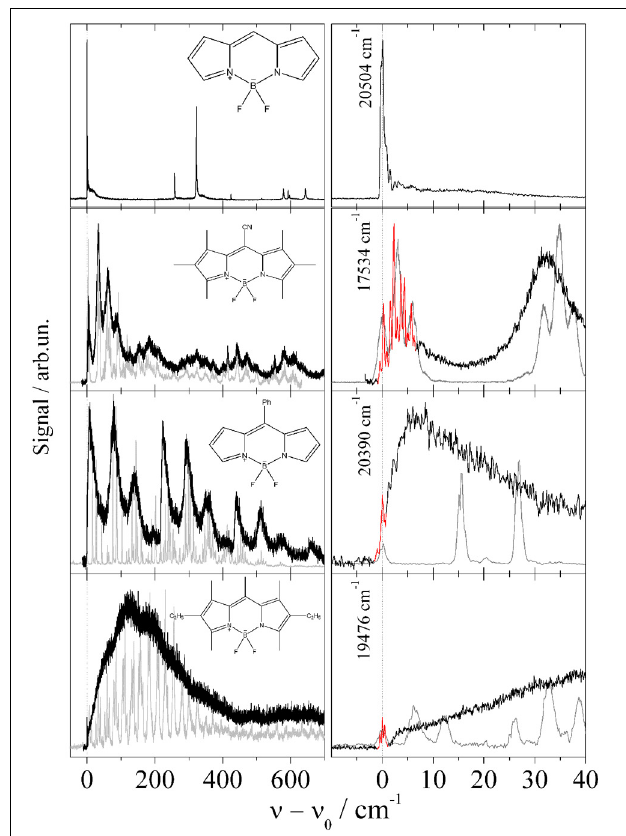
FIGURE 3 | Electronic origin of six Porphyrin derivatives, Diphenylporphyrin (DPP), Tetraphenylporphyrin (TPP), Tetramethylporphyrin (TMP), Tetrapropylporphyrin (TPrP), Tetraethyltetramethylporphyrin (Etio), and one chlorine compound Tetraphenylchlorin (TPC). For high photon flux (gray lines) saturation broadening and intense PW hides the fine structure (black line) observed for greatly reduced photon